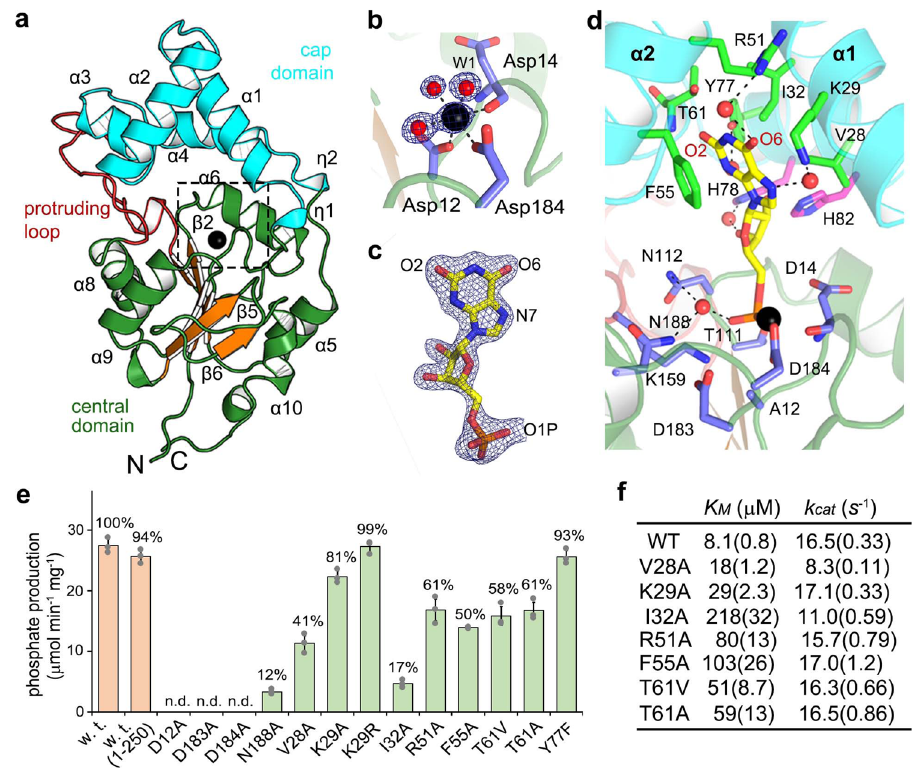
Fig. 4 Structural and mutational analysis of XMPP. a Structure of the unliganded XMPP. The repeating β – α units (organge, green) in the central domain include β 1 – α 5, β 2 – α 6, β 3 – α 8, β 4 – α 9, and β 6 – α 10. Metal-binding site, dashed box. Mg 2 + ion, black sphere; cap domain, cyan; protruding loop, red. b A zoomed-in view of the proposed Mg 2 + -binding site. Dashed lines indicate the six coordination bonds. Asp12 and water W1, axial ligands. Asp184, the main chain carbonyl oxygen of Asp14 and two water, equatorial ligands. Water (red) and metal ion (black) are overlaid with a 2 F o − F c electron density map contoured at 1.0 σ and 3.0 σ , respectively. c XMP as oriented in the structure of the complex overlaid with an F o − F c electron density map contoured at 3.5 σ